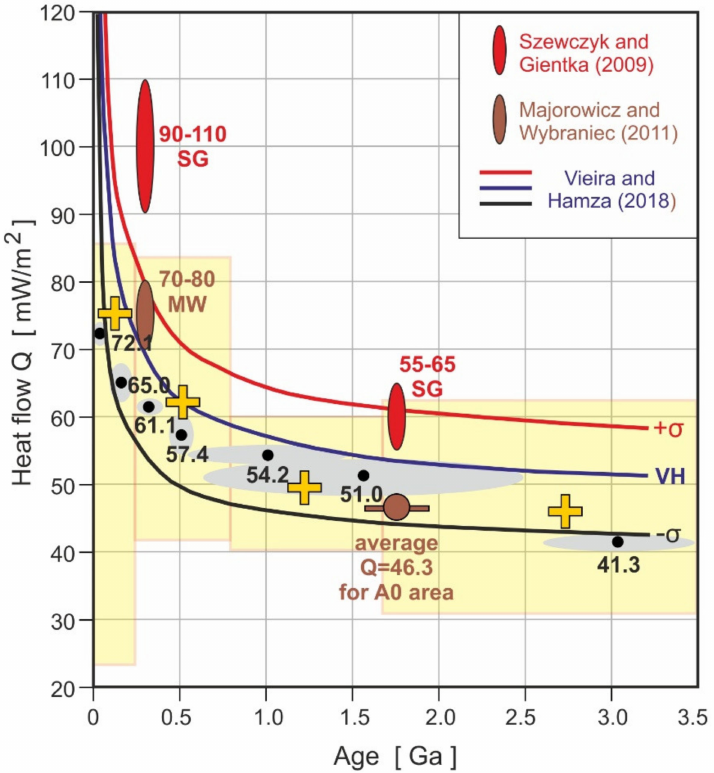
Figure 6. Comparison of average values of the continental heat flow Q for tectonic units of different age. Averaged values, for “13 BB Star” array in northern Poland (marked A0) is shown by big brown dot with line of age range. Average heat flow-age groups from Szewczyk and Gientka [17] marked SG (red ellipses), and Majorowicz and Wybraniec [22] marked MW (brown ellipses), differs significantly. MW data fit the expected heat flow versus age relationship much better. Heat flow-age compiled from Jessop et al. [29] and Majorowicz and Jessop [14] are shown by yellow crosses with the range shown yellow areas. Heat flow vs. age relationship lines marked by VH and the standard deviation bounds (_+ σ and − σ ) are from Vieira and Hamza